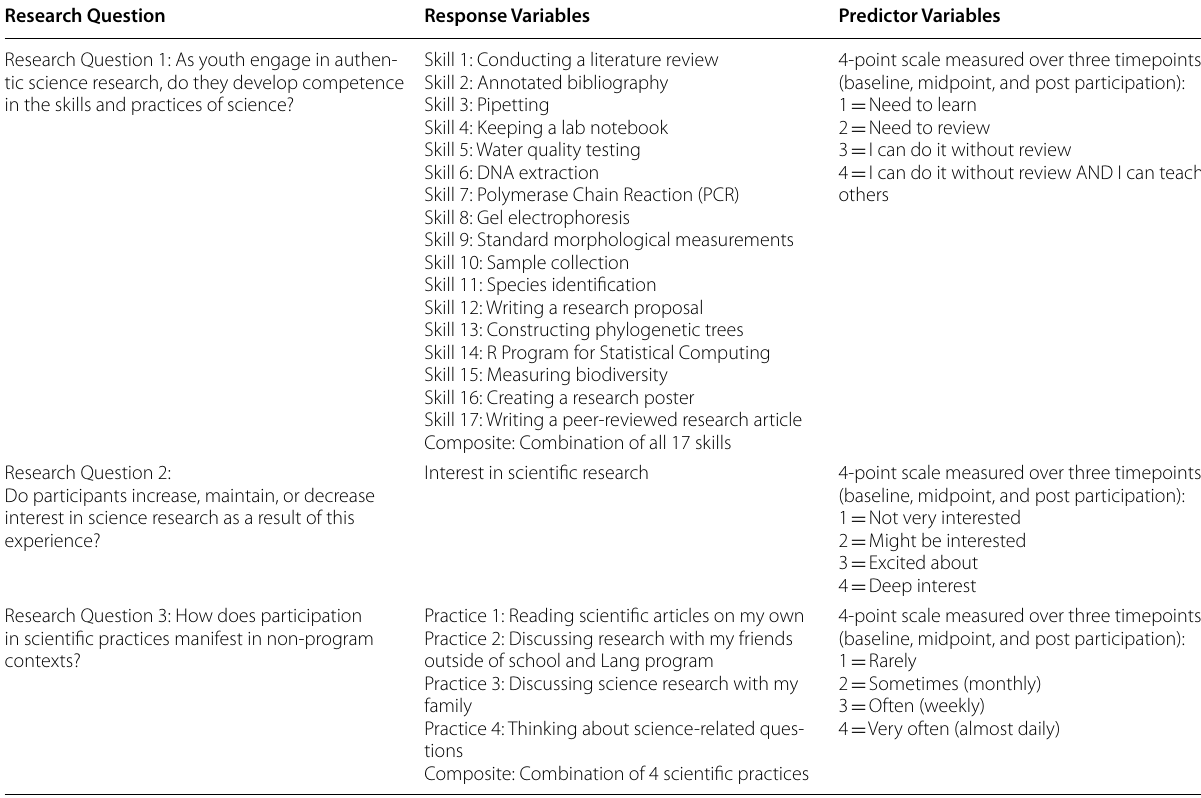
Table 4 Predictor variables and response variables modeled for quantitative analyses (repeated measures ANOVA) Research